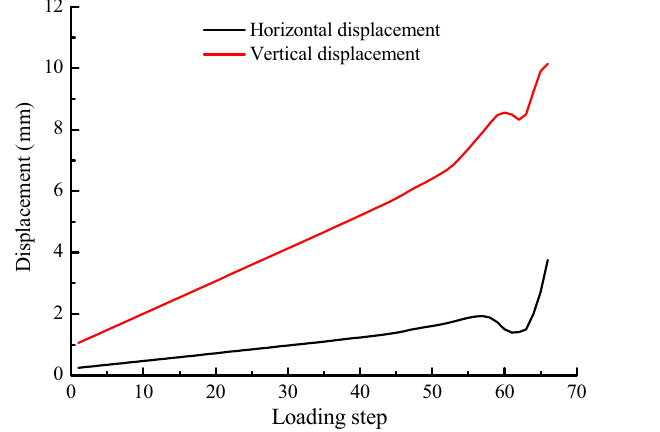
Figure 9. Point P displacement curve of landslide